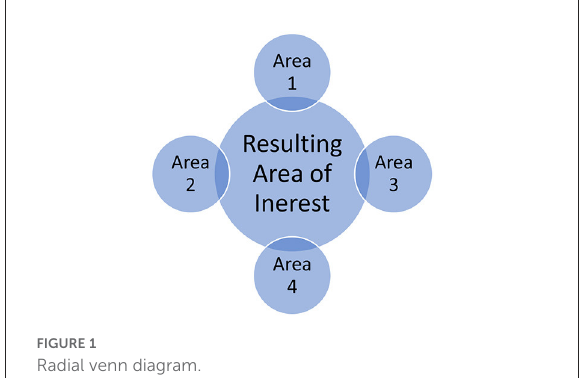
FIGURE1 Radial venn diagram.